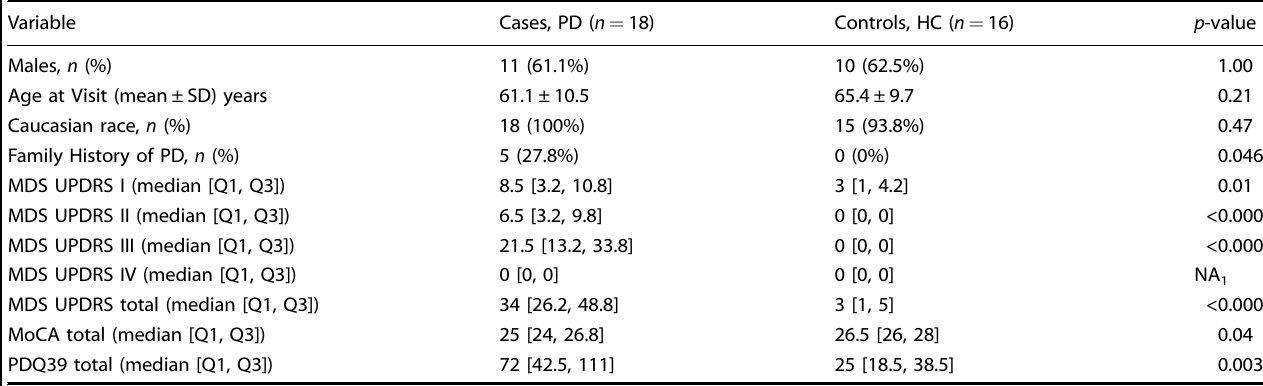
Table 1. Cohort characteristics.